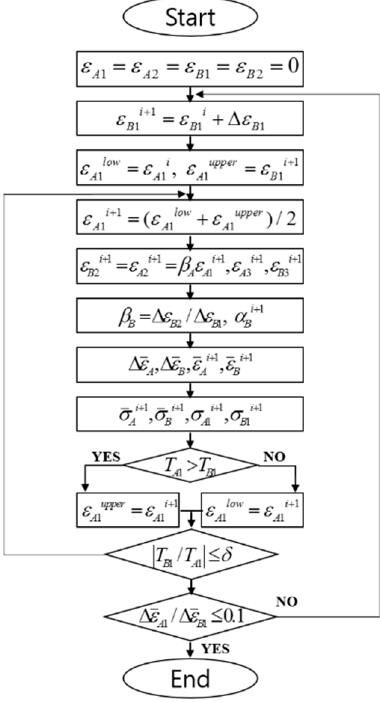
Figure 11. Flow chart for acquisition of forming limit diagram.